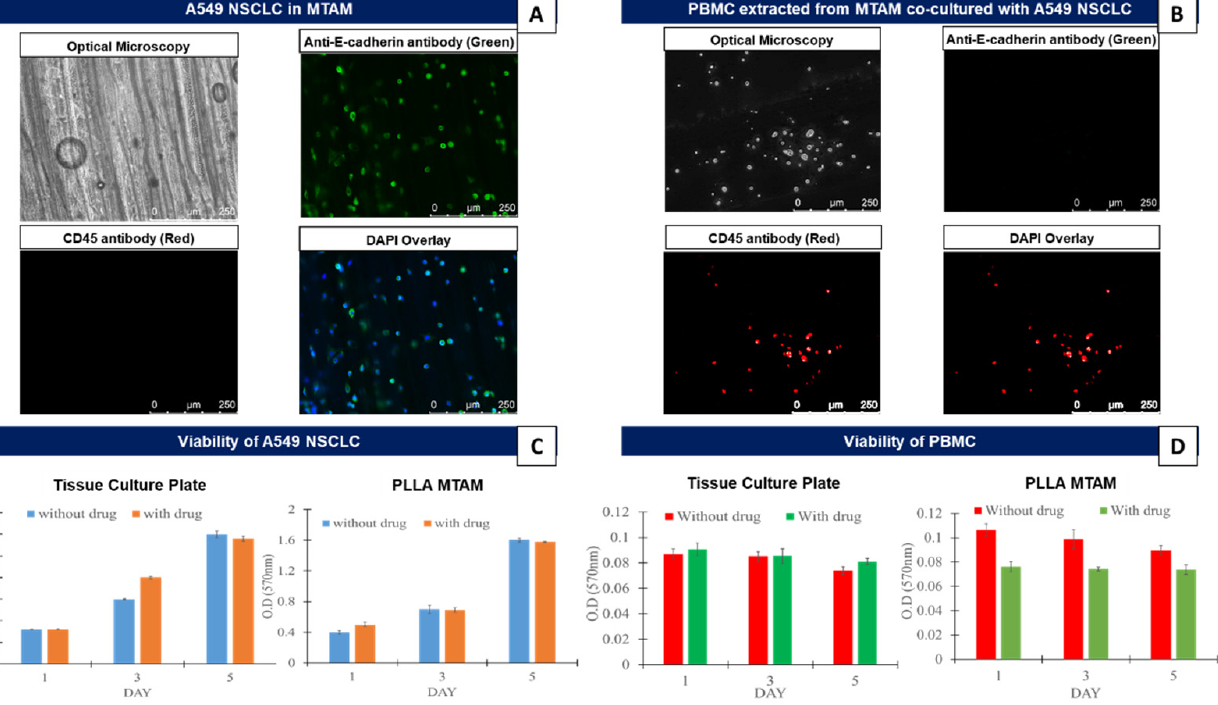
Figure 1. ( A ) Fluorescent microscopy of A549 cancer cell line co-cultured with PBMC in the PLLA MTAM; and extracted A549 cancer cell line stained with CD45 (non attaching cells), anti-E-cadherin (surface attaching cells) and DAPI. ( B ) Extracted PBMCs that were previously co-cultured with the A549 cancer cell line stained with the above outlined markers. ( C , D ) Comparison of the viability of the A549 cancer cell line and PBMCs that were monocultured in standard tissue culture plates (TCPs) and within the respective PSF MTAMs under two different conditions: with and without the corresponding anti-PD1